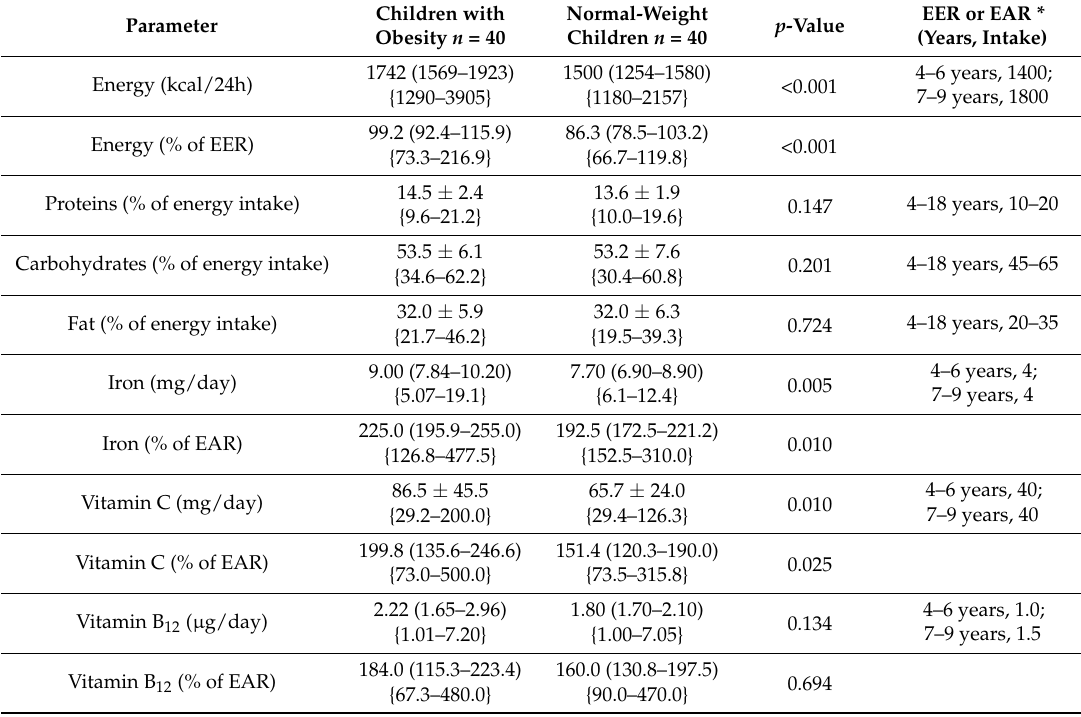
Table 3. Daily energy and nutrient intake of the examined children compared with recommended daily